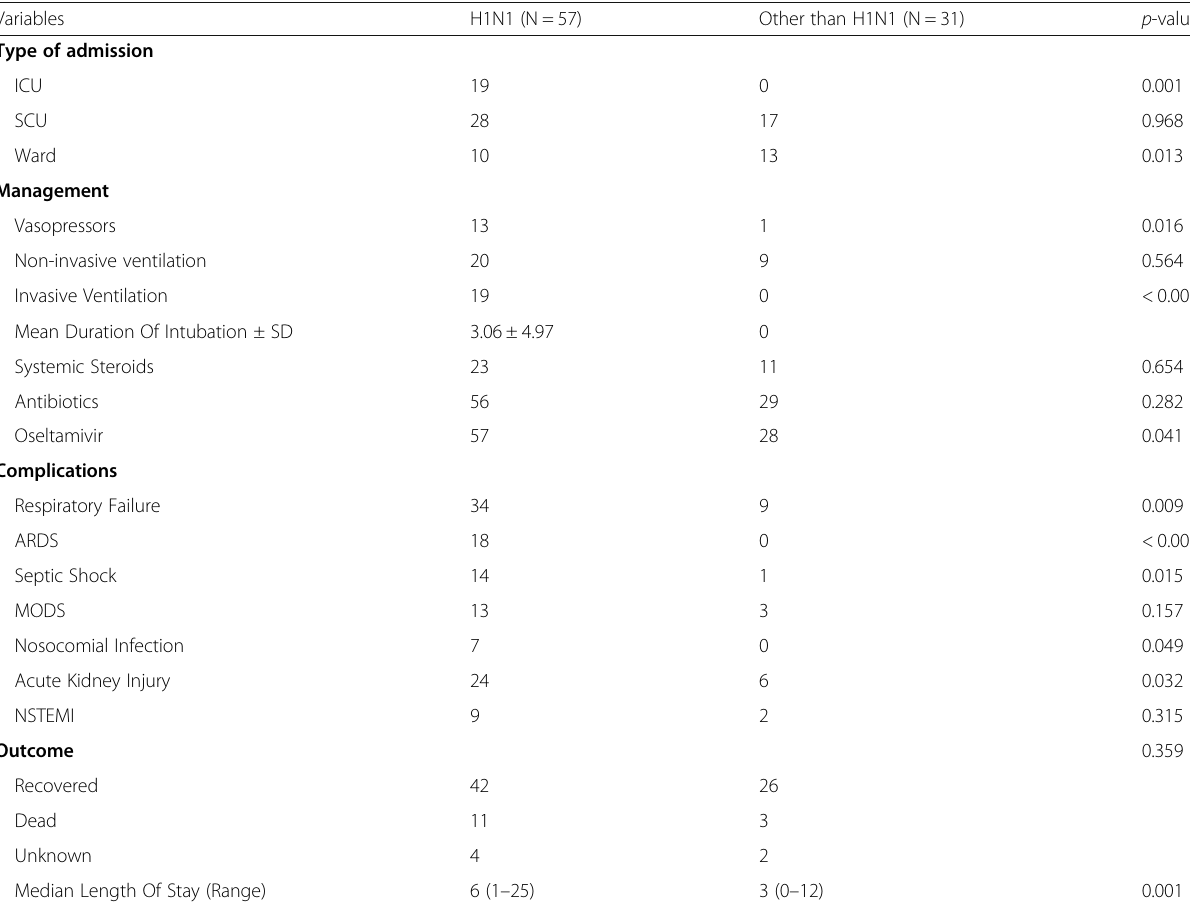
Table 2 Outcomes and Complications of patients with Influenza subtype H1N1 compared to other than H1N1 during the outbreak of